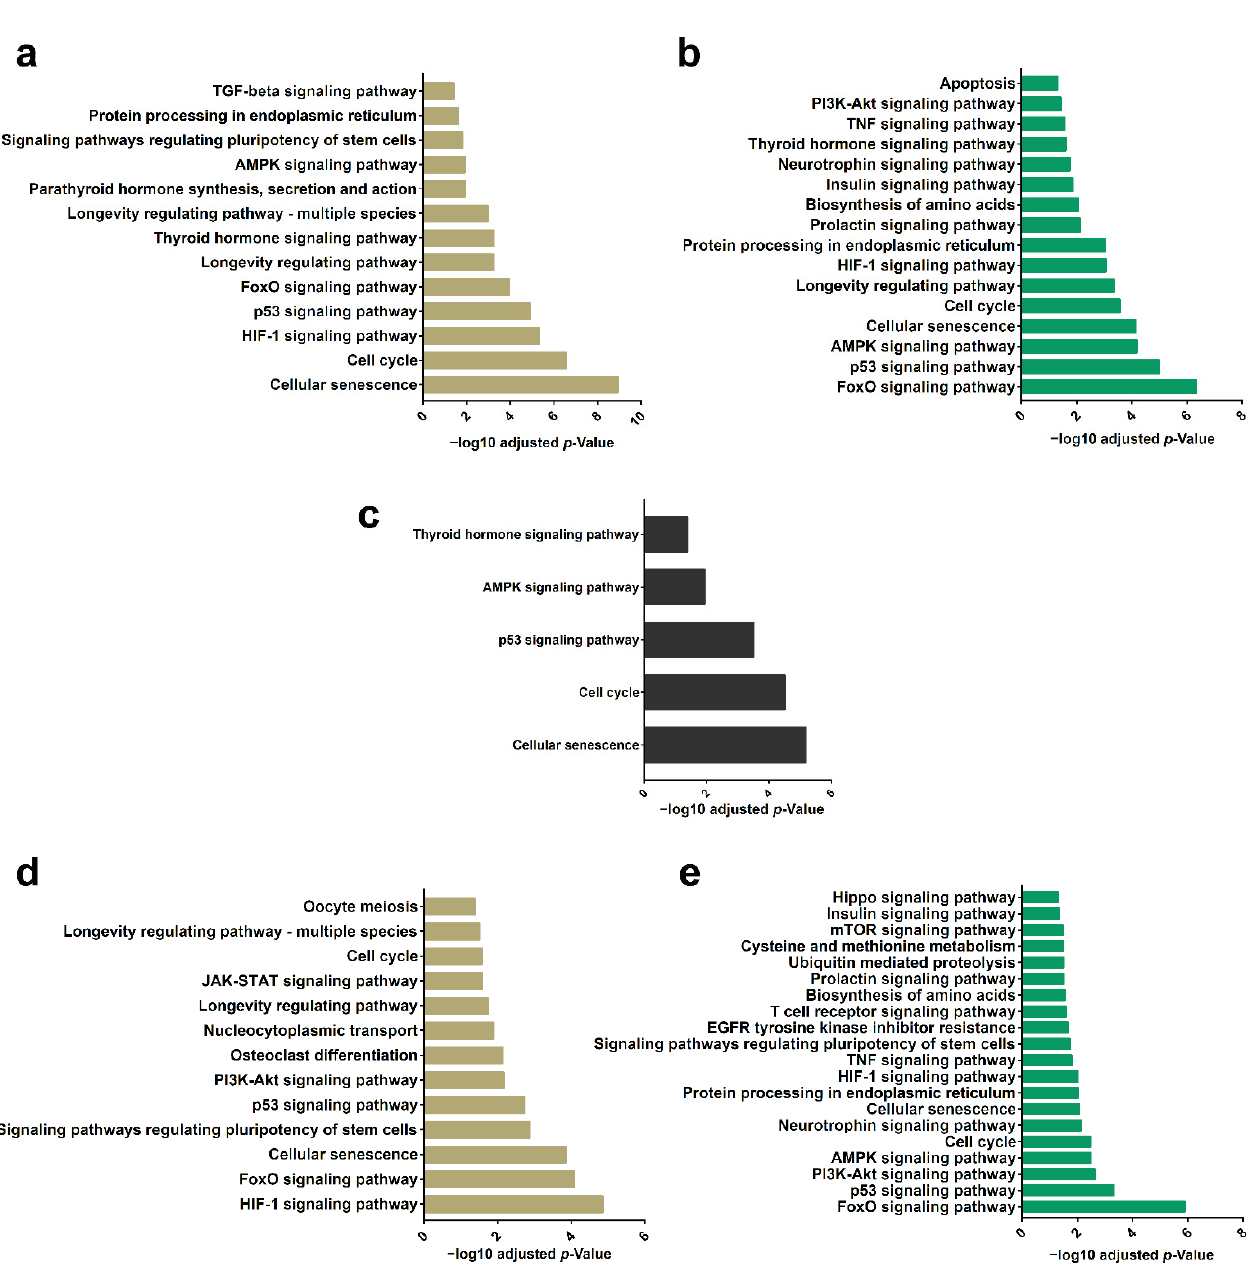
Figure 5. Analysis of miRNA targets and their regulated pathways. ( a ) KEGG analysis of mRNA targets of top 10 miRNAs enriched in H-EVs (vs. H-cells). ( b ) KEGG analysis of mRNA targets of top 10 miRNAs enriched in N-EVs (vs. N-cells). ( c ) KEGG analysis of mRNA targets of the six miRNAs more expressed in H- and N-EVs in comparison with cells. ( d ) KEGG analysis of mRNA targets of the four miRNAs more expressed in E-CD133 EVs in comparison with E-CD133 only in hypoxia condition. ( e ) KEGG analysis of mRNA targets of the four miRNAs more expressed in E-CD133 EVs in comparison with E-CD133 only in normoxia condition.